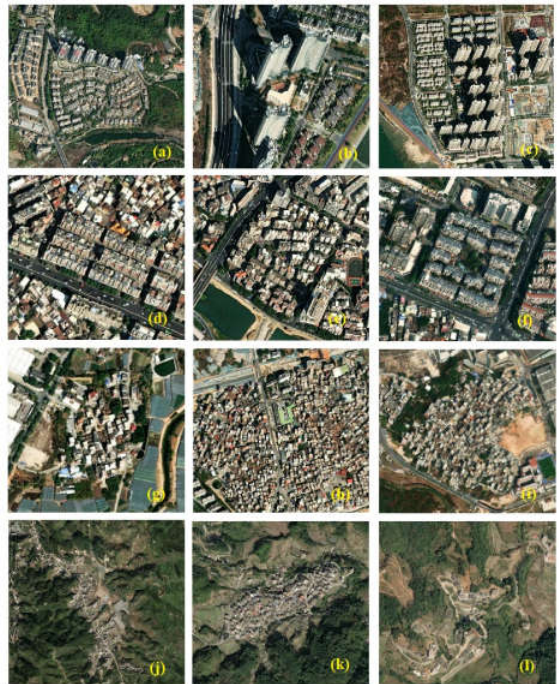
Figure 1 . Typical residential communities in Tong’an District. (a)~(c): Newly built community in urban area (NCU); (d)~(f): Old community in urban area (OCU); (g)~(i): Mixed community in the rural-urban fringe (MC); (j)~(l): Village community in rural area